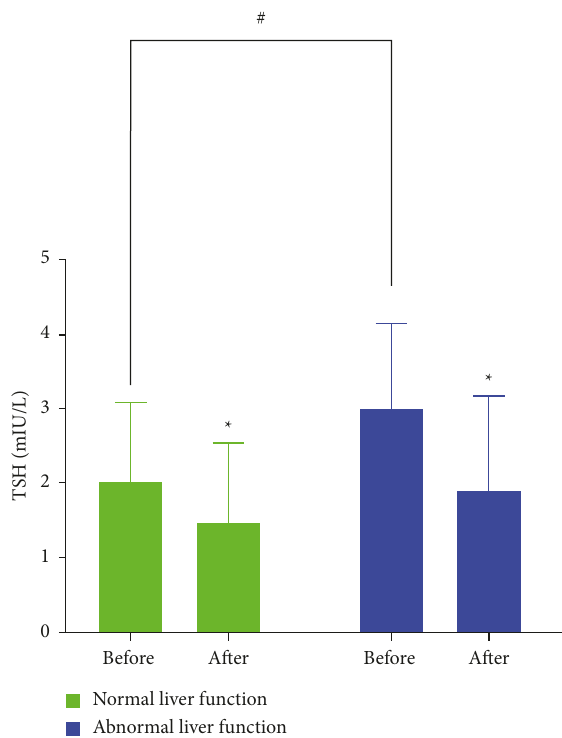
Figure 4: Concentration of TSH before and after liraglutide treatment stratified by status of liver disease. ∗ p < 0 . 05 vs. corre- sponding baseline data; # p < 0.05 vs. baseline normal liver function